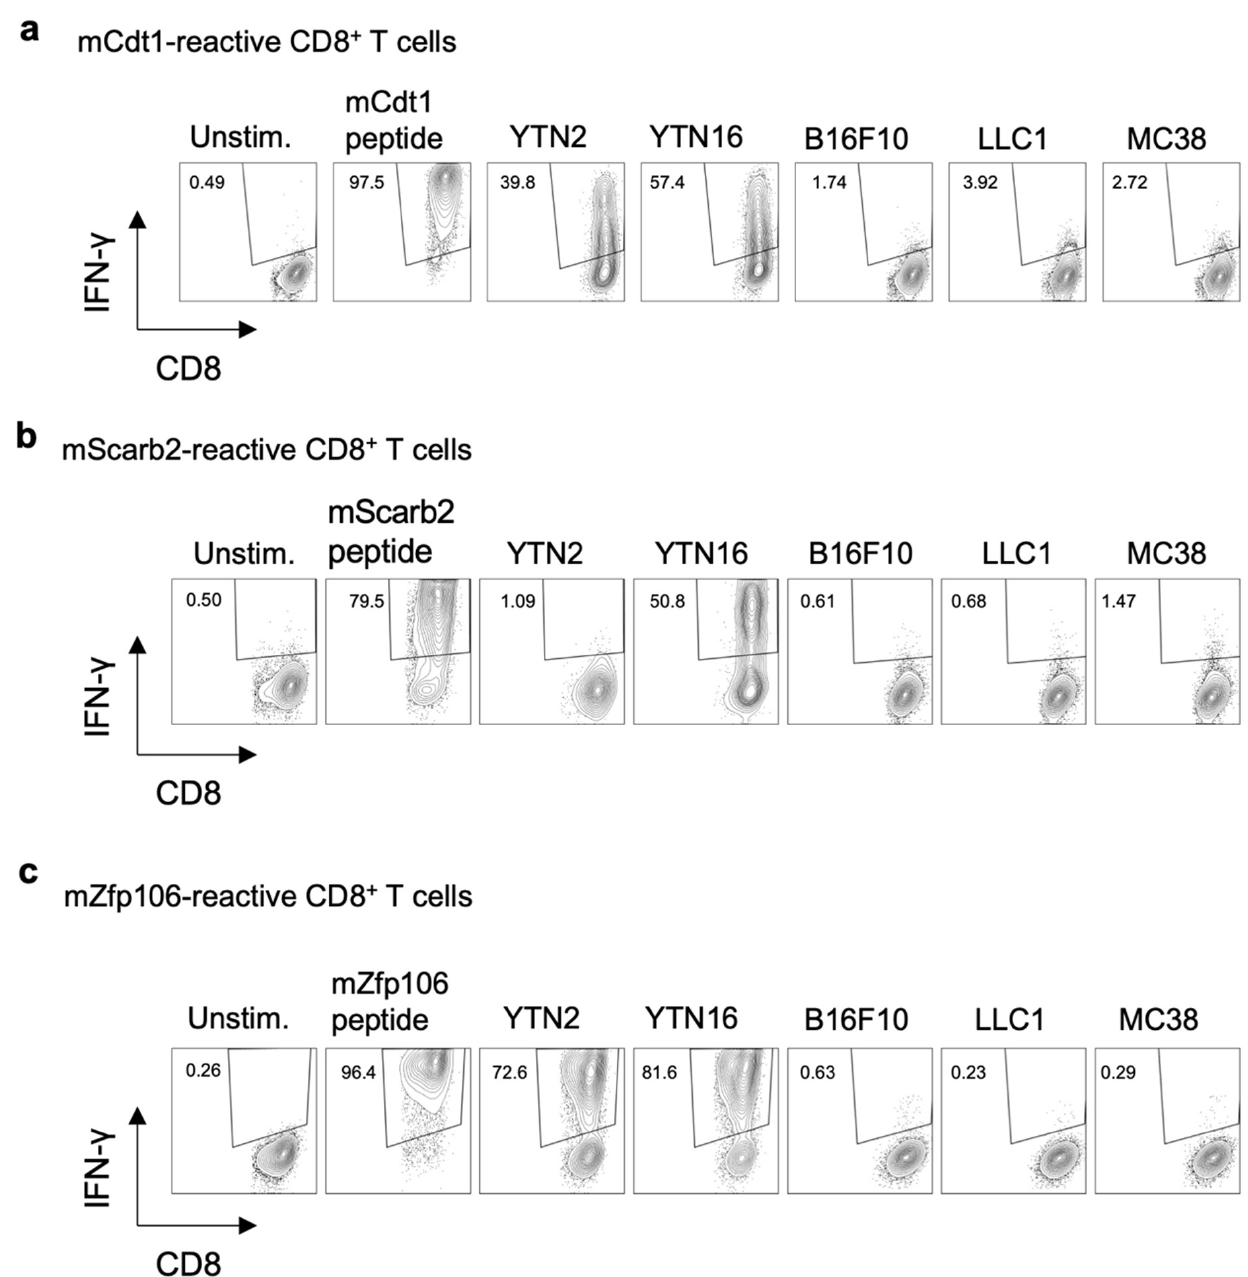
Figure 3. Three neoantigen-reactive CD8 + T cell lines. The established neoantigen-reactive CD8 + T cell lines were stimulated with the indicated peptides or cells, and their reactivity was evaluated by IFN- γ production: ( a ) mCdt1-reactive CD8 + T cells responded to YTN2 and YTN16; they did not respond to B16F10, LLC1 or MC38 cell lines. ( b ) mScarb2-reactive CD8 + T cells responded to YTN16; they did not respond to YTN2, B16F10, LLC1, or MC38 cell lines. ( c ) mZfp106-reactive CD8 + T cells responded to YTN2 and YTN16; they did not respond to B16F10, LLC1, or MC38 cell lines.